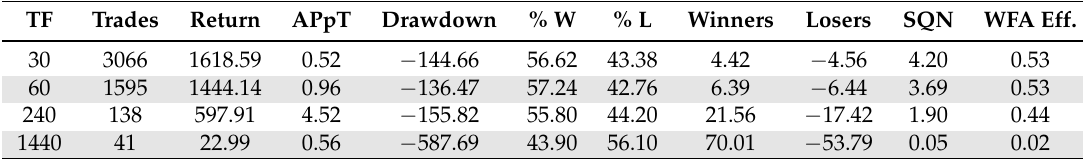
Figure 11. Vertical lines are coloured for the beginning of each of the out of sample periods. It can be seen how the first half of the historical data coincides with the first in-sample period, while the second half coincides with the whole out-of-sample ensembled data. Table 6. The highest timeframe is not profitable out of sample. SQN values are better for lower timeframes, where we have more trades. However, the APpT is smaller in these cases. The APpT shown here is the weighted average of the APpT, whose weights are the number of trades at each out of sample